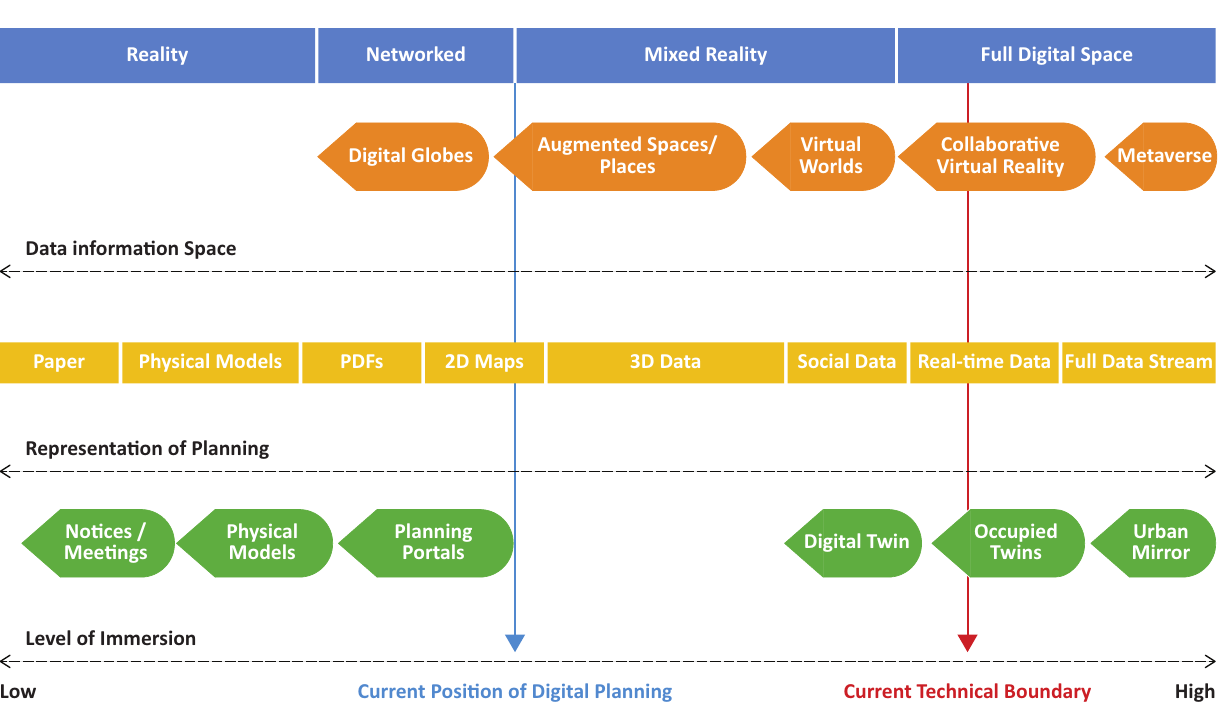
Figure 1. A timeline and current position of digital planning and its move towards the